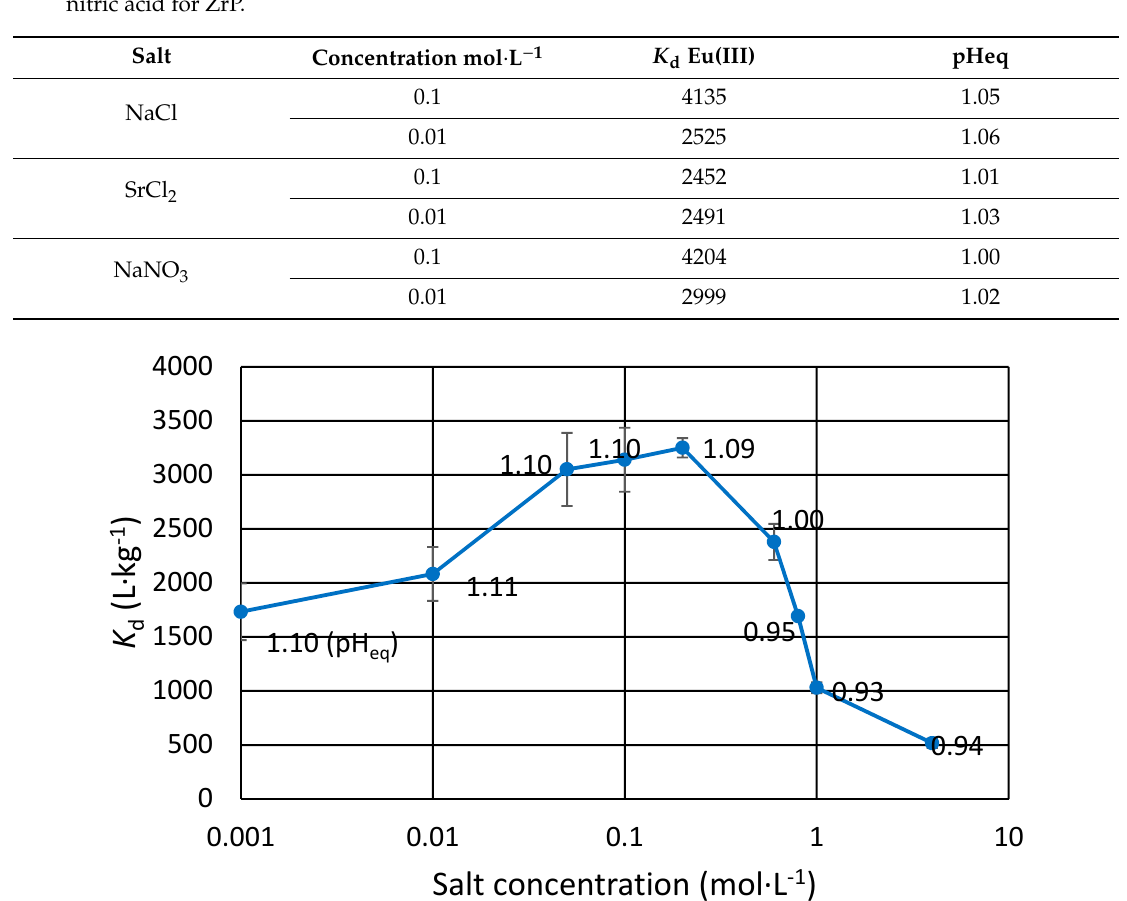
Figure 1. Distribution coe ffi cient for trace Eu(III) as a function of sodium nitrate concentration, from 0.001 mol · L − 1 to 4 mol · L − 1 . Values next to the data points are the measured equilibrium pH values. The relative uncertainties for the presented values are between 1% and 15%.